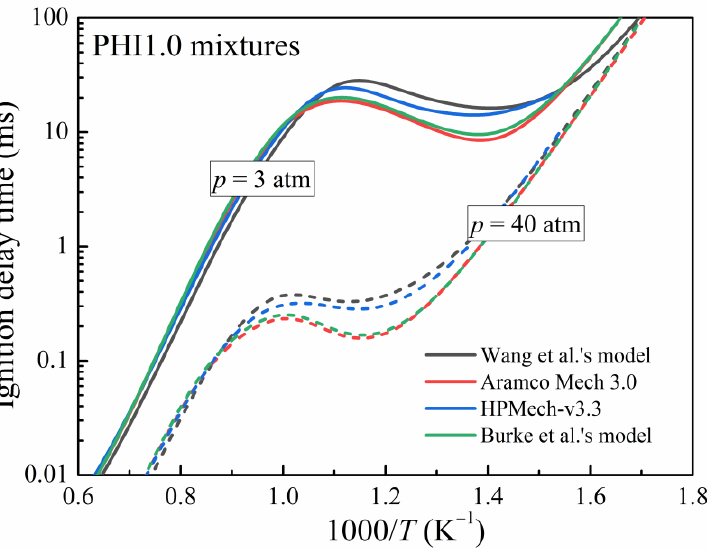
Figure 2. Simulated ignition delay times of PHI1.0 DME/ ‘air’ mixtures with various kinetic models [27,31 – 33] at pressures of 3 atm and 40 atm.